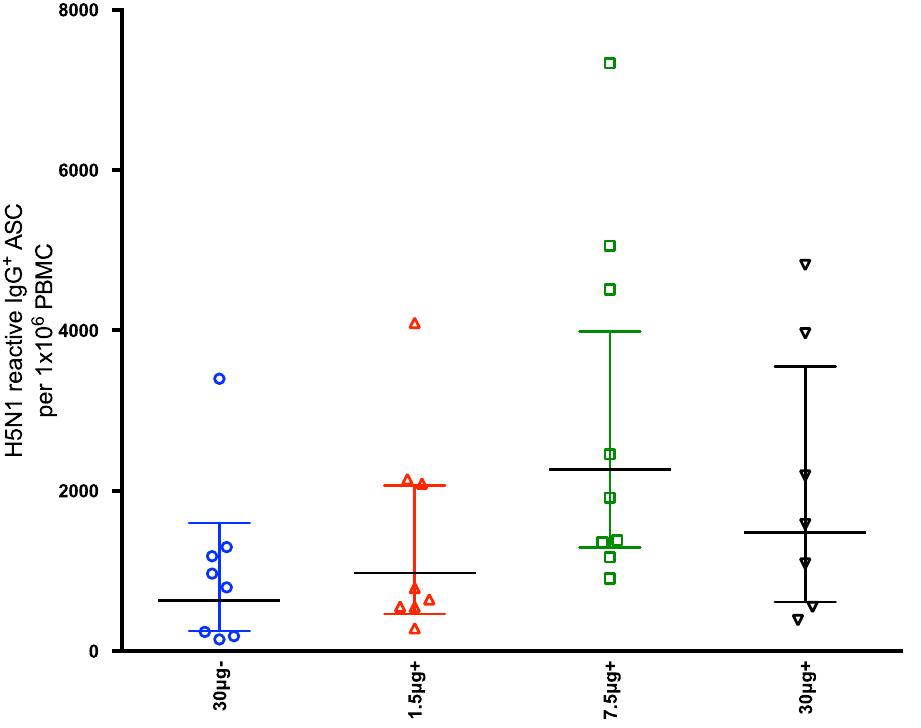
Fig 9. The memory B cell (B mem ) response 365 days after vaccination. Subjects were vaccinated with two doses (21 ± 1 days apart) of inactivated virosomal H5N1 vaccine alone (30 μ g HA, blue) or 1.5 (red), 7.5 (green) or 30 μ g HA (black) adjuvanted with Matrix-M (50 μ g). The B mem response at 365 days post-first vaccination was analyzed by ELISPOT. The bars represent the mean number of NIBRG-14-specific B mem per 1×10 6 peripheral blood mononuclear cells (PBMC) ± standard error of the